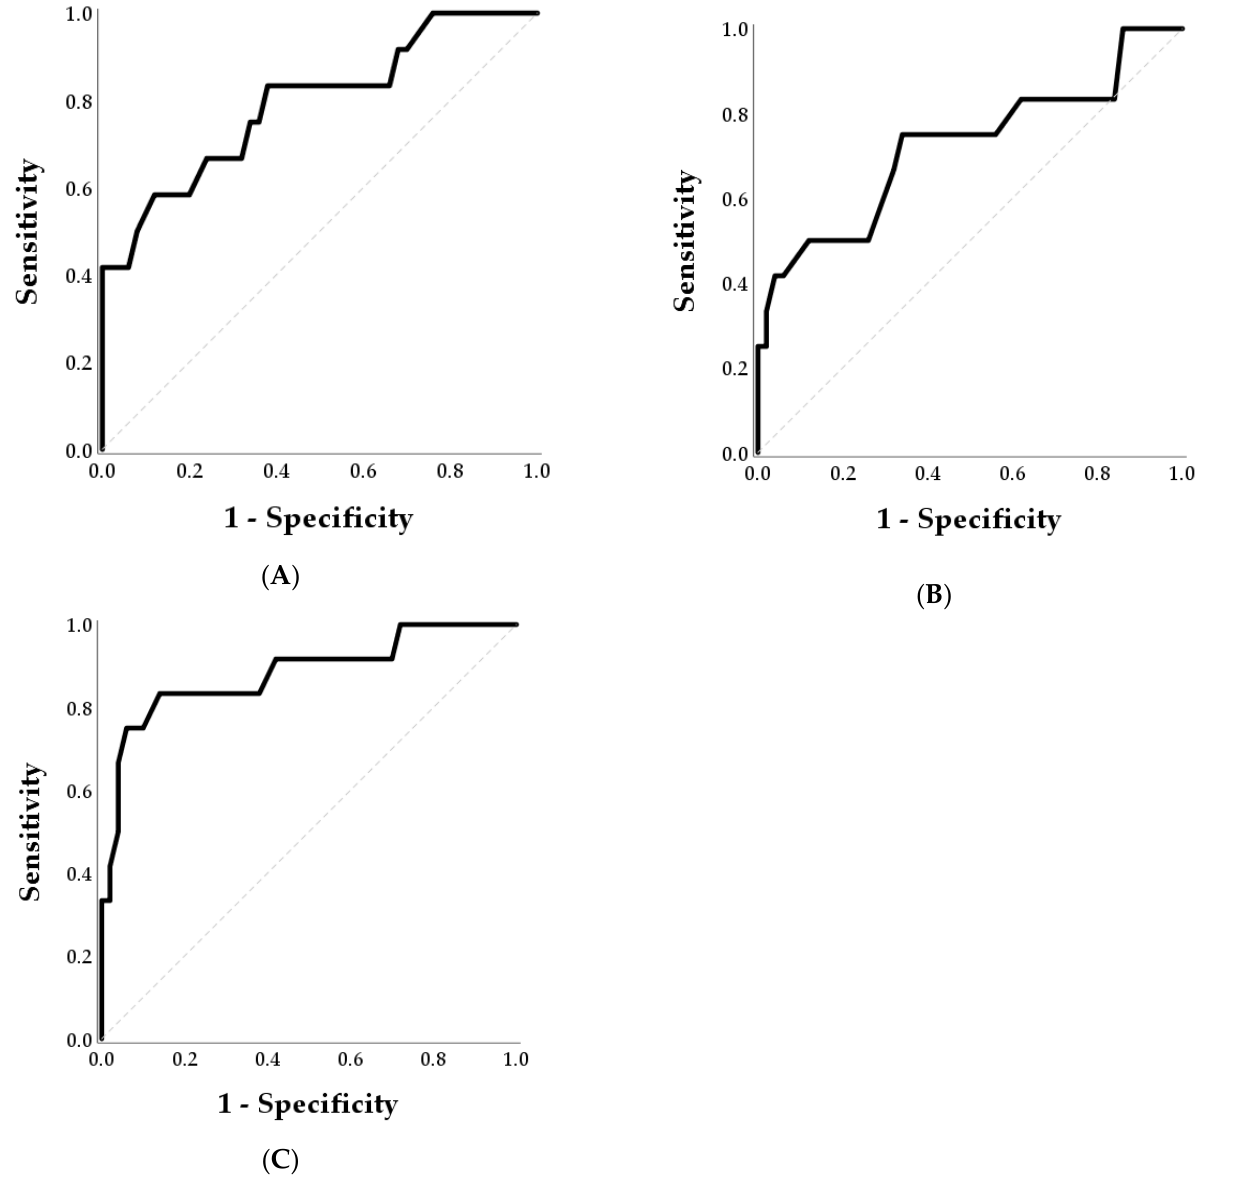
Figure 2. Receiver operating characteristics curves for the detection of embryonic mortality by P4 at days 25 (Panel A ), 28 (Panel B ), and 40 (Panel C ) post-AI. Optimal cut-offs for predicting mortality were 2.6 ng/mL, 2.6 ng/mL, and 2.4 ng/mL at days 25, 28 and 40 post-AI, respectively.